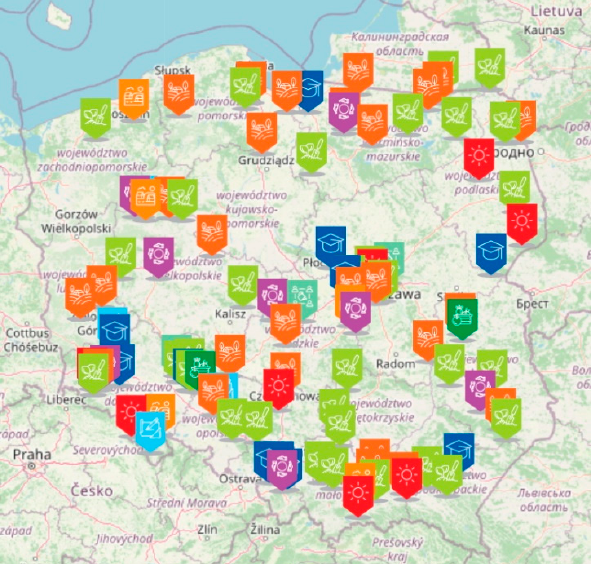
Figure 2. Map of permaculture initiatives in Poland developed by PermaKultura.Edu.PL (image source: https://mapa.permakultura.edu.pl, accessed on 13 November